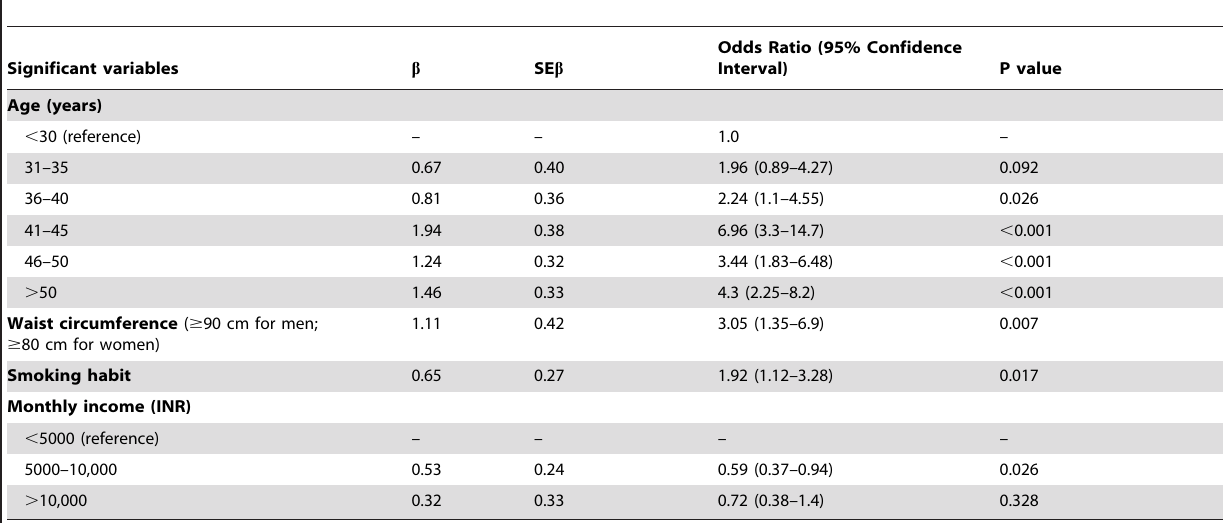
Table 5. Results of multinomial logistic regression analysis (Pre-diabetes vs. Non-diabetes; dependent variable).